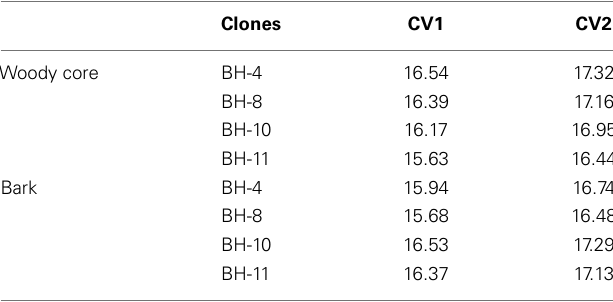
Table 4 | Energy content of wood and bark biomass based on model calculation (unit: